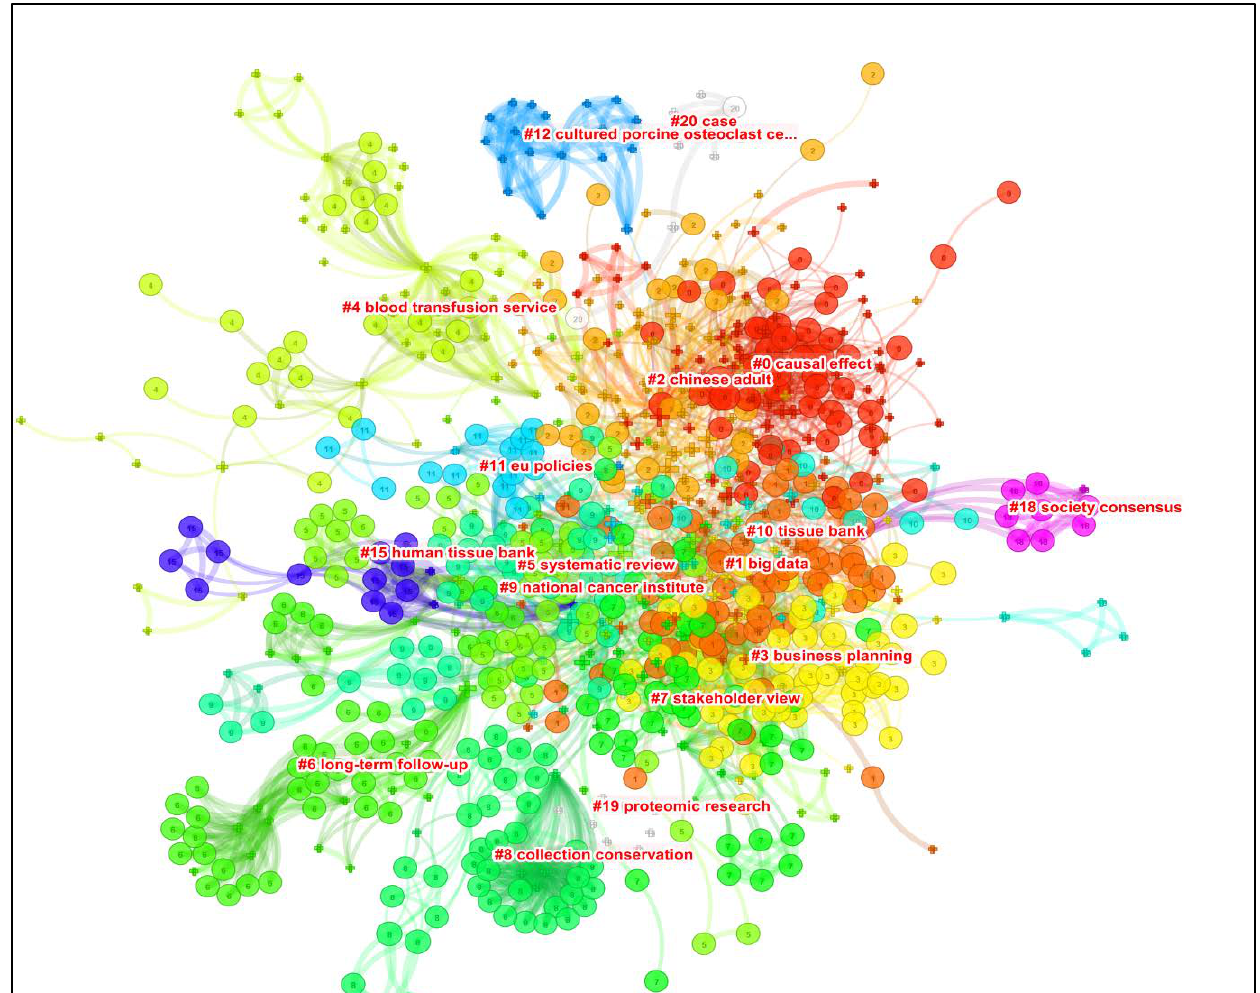
Figure 2. Overview of the co-citation network for 1990 studies: clusters labels by keywords. Source: authors’ visualisation in the CiteSpace software (Chen 2017).